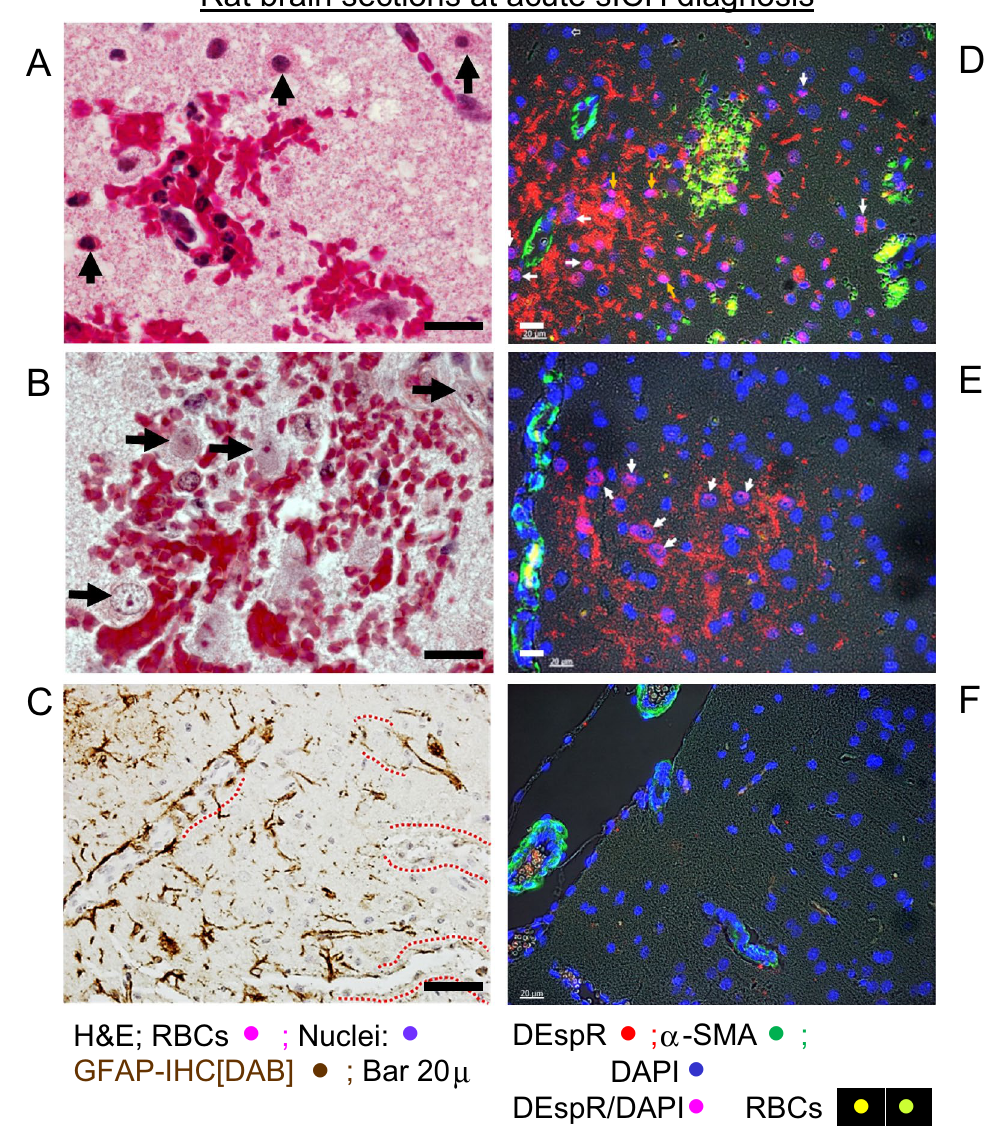
Figure 2. Representative histopathological analysis of rat brain sections at sICH detection. ( A ) H&E staining of microbleed area with neutrophil infiltrates; ↑ pyknotic, eosinophilic neurons. ( B ) H&E staining of microbleed area with no neutrophils: neurons not pyknotic nor eosinophilic. ( C ) Immunohistochemistry- DAB staining of GFAP; dashed red line ( ---- ) mark microvessels with non-contiguous GFAP immunostaining suggesting BBB disruption. ( D , E ) Representative immunofluorescence staining of sICH rat brain sections at acute ICH detection; white arrows → DEspR+ neutrophils examples. Red DEspR+ anuclear fragments noted. ( F ) IF-staining of age-matched non-ICH Dahl S rat brain section. DEspR+ (red); RBCs, red blood cells autofluorescence (yellow-green); αSMA, alpha smooth muscle alpha actin (green) serves as positive-IF control for microvessels; DAPI, nuclear stain; merged DEspR+ DAPI+, magenta. Bar 20